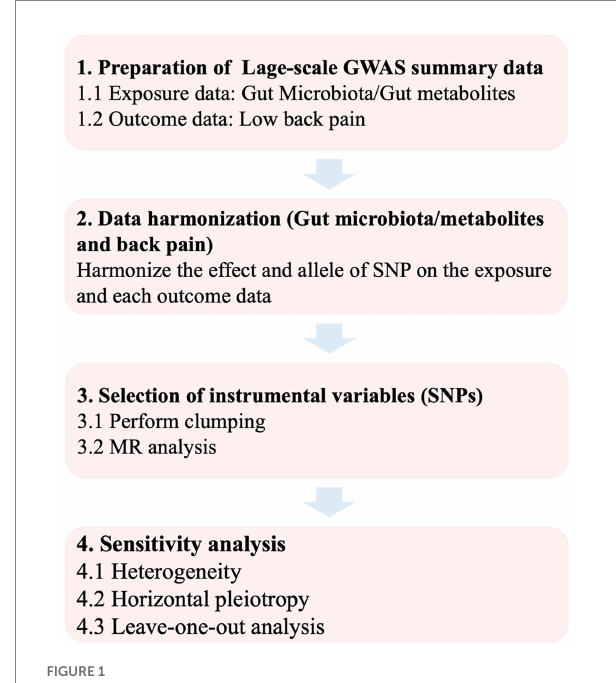
FIGURE 1 Flowchart of the study. GWAS, genome-wide association study; SNP, single-nucleotide poly-morphism; MR, Mendelian